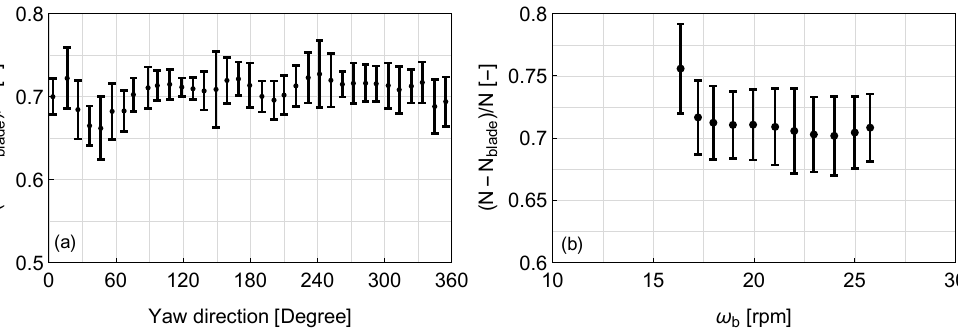
Figure 12. Mean data availability, defined here by the relative difference between the total amount of measurements 𝑁 and the number of blade signals detected 𝑁 𝑏 per ( a ) yaw direction and ( b ) rotor speed, over a 10 min period. The error bars correspond to one standard deviation about the